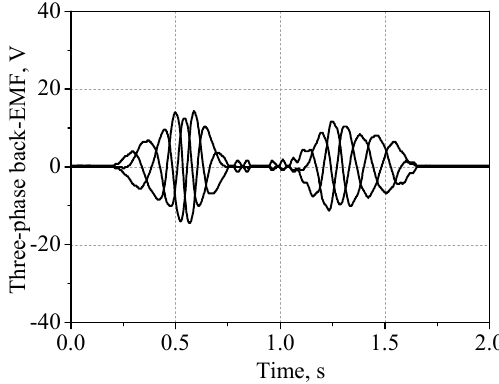
Figure 18. The three-phase back-EMF waveforms for the wave period and height of 2 s and 0.25 m, respectively, in the wave tank.